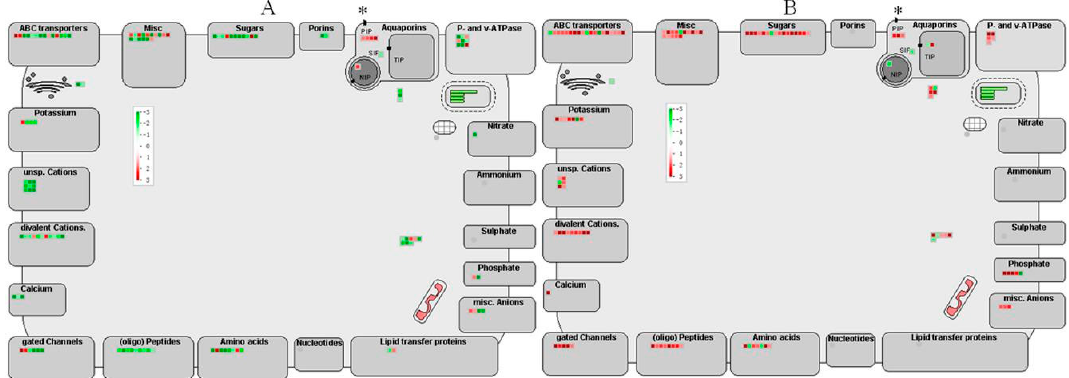
Figure 4. MapMan views of transport related genes that were differentially regulated after C Las infection at 13 ( A ) and 26 wpi ( B ). Genes significantly upregulated by C Las are displayed in red, and the downregulated are shown in green. * PIP (plasma membrane intrinsic protein) genes; SIP : small and basic intrinsic protein genes; NIP : Nod26-like intrinsic protein genes; TIP : tonoplast intrinsic protein genes; grid framed with ellipse represents chloroplast.